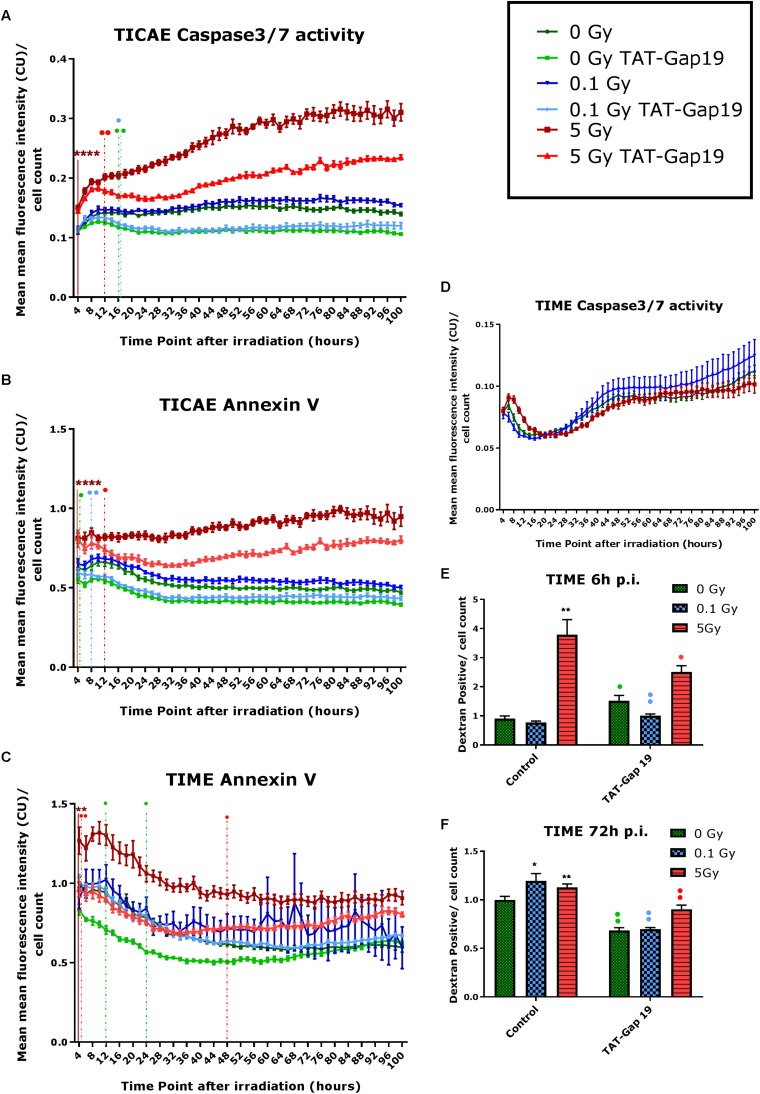
Radiation-induced cell death as assessed by Caspase 3/7 activity, Annexin V and 10 kDa dextran fluorescein staining, and effect of TAT-Gap19. (A,D) Caspase 3/7 activity in TICAE and TIME cells from 4 to 100 h p.i., (B,C) Annexin V level in TICAE and TIME cells from 4 to 100 h p.i. assessed by Incucyte live cell imaging of the mean fluorescence intensity measured in Calibrated Unit (CU) that takes into account acquisition time and fluorescent intensity. (E,F) Dextran fluorescein stained TIME cells at 6 and 72 h p.i. The values represent the average ± SEM of 6–8 biological replicates; statistical analysis was done with non-parametric two-way ANOVA followed by a Tukey test for Annexin V and Caspase 3/7 activity, and with a non-parametric Mann–Whitney T-test for the dextran fluorescein assay. *Indicates statistically significant differences compared to the respective 0 Gy controls. •Indicates statistically significant differences between the TAT-Gap19 group compared to the corresponding respective control conditions (not treated with TAT-Gap19). */•p < 0.05; **/••p < 0.01; ***/•••p < 0.0001, ****/••••p < 0.00001.